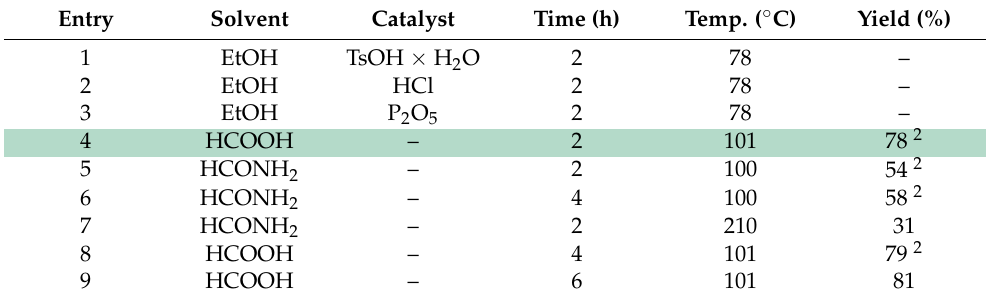
Table 1. Optimization of intramolecular oxidative cyclization conditions 1 .